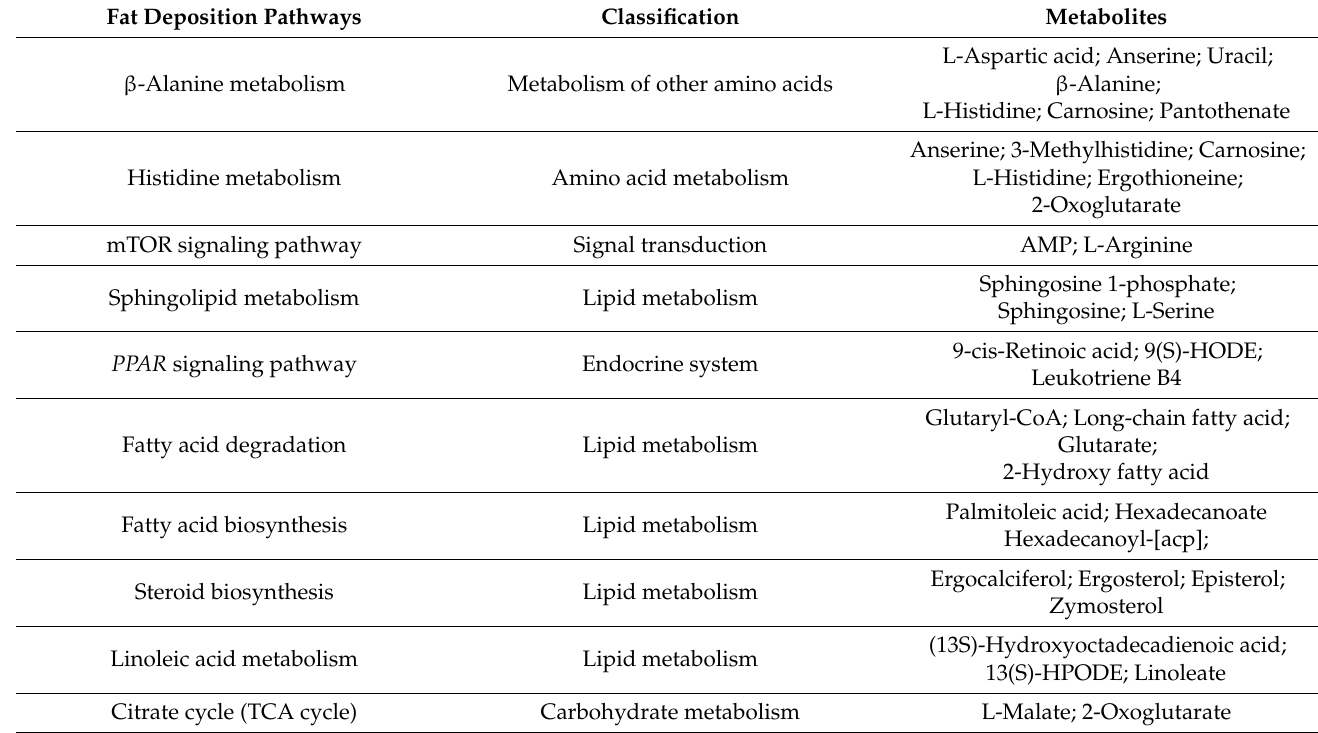
Table 10. Basic information of related pathways.